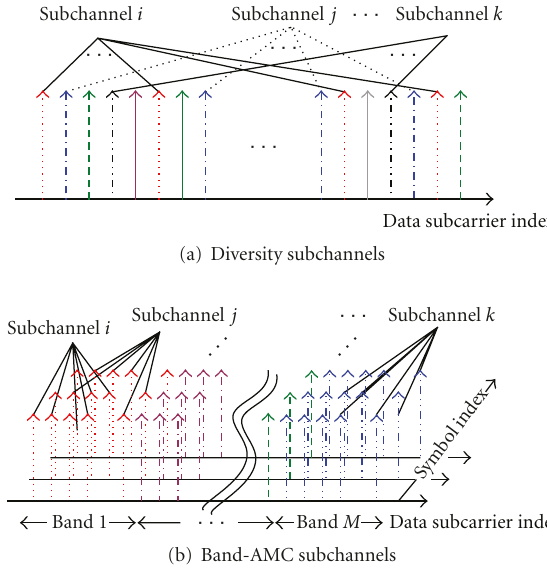
Figure 1: Construction of diversity and band-AMC